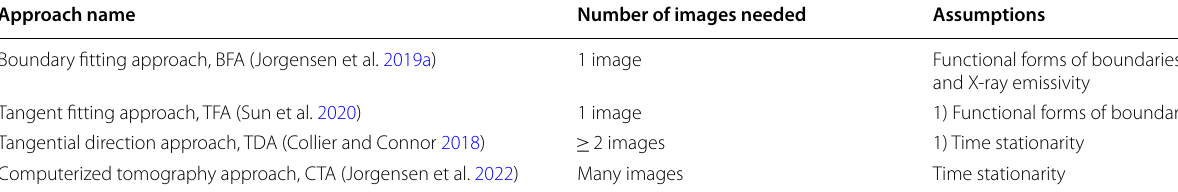
Table 1 Summary of magnetopause reconstruction